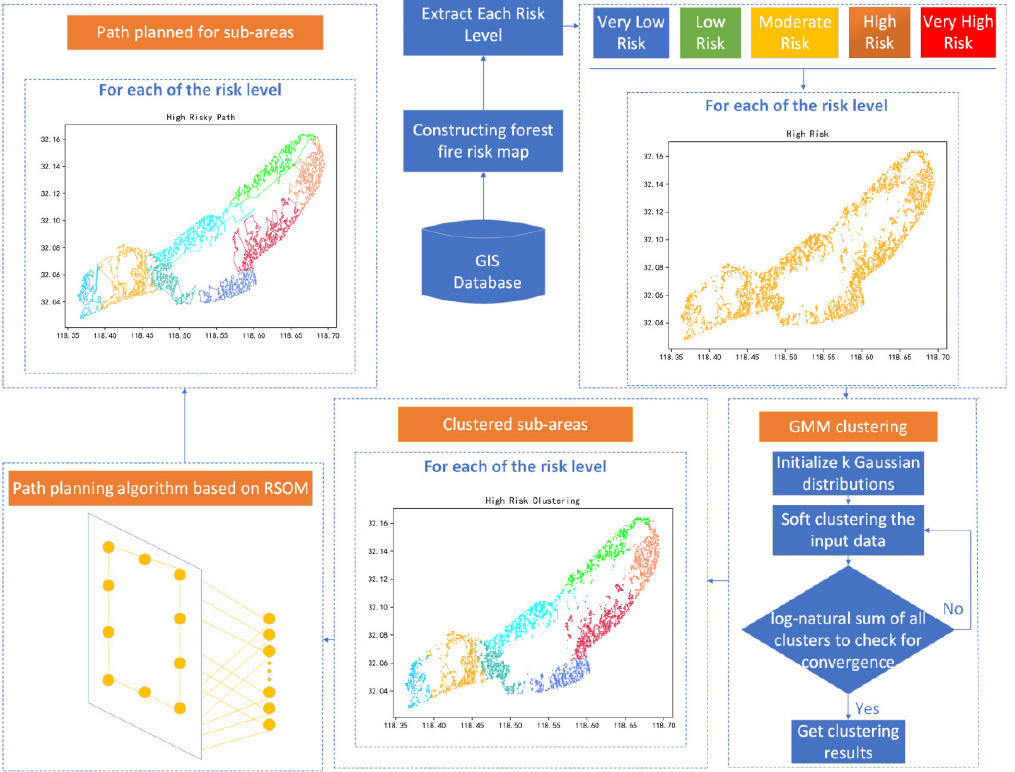
Figure 1. Flowchart of proposed